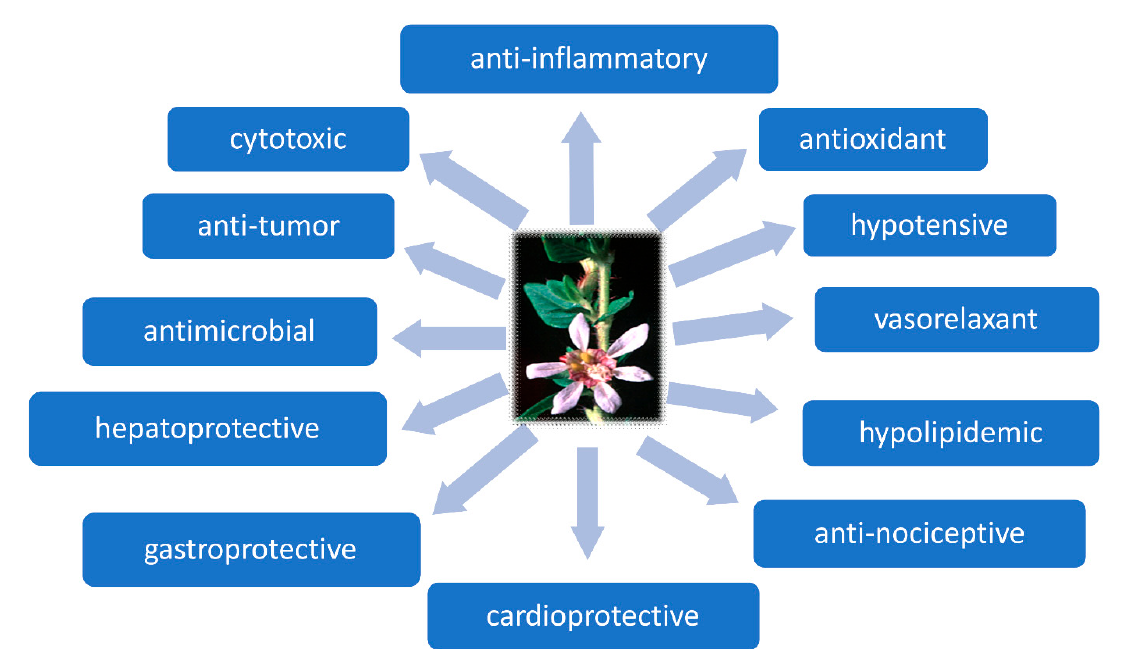
Figure 8. Biological activity of Cuphea extracts. Table 4. The results of pharmacological studies on Cuphea sp.